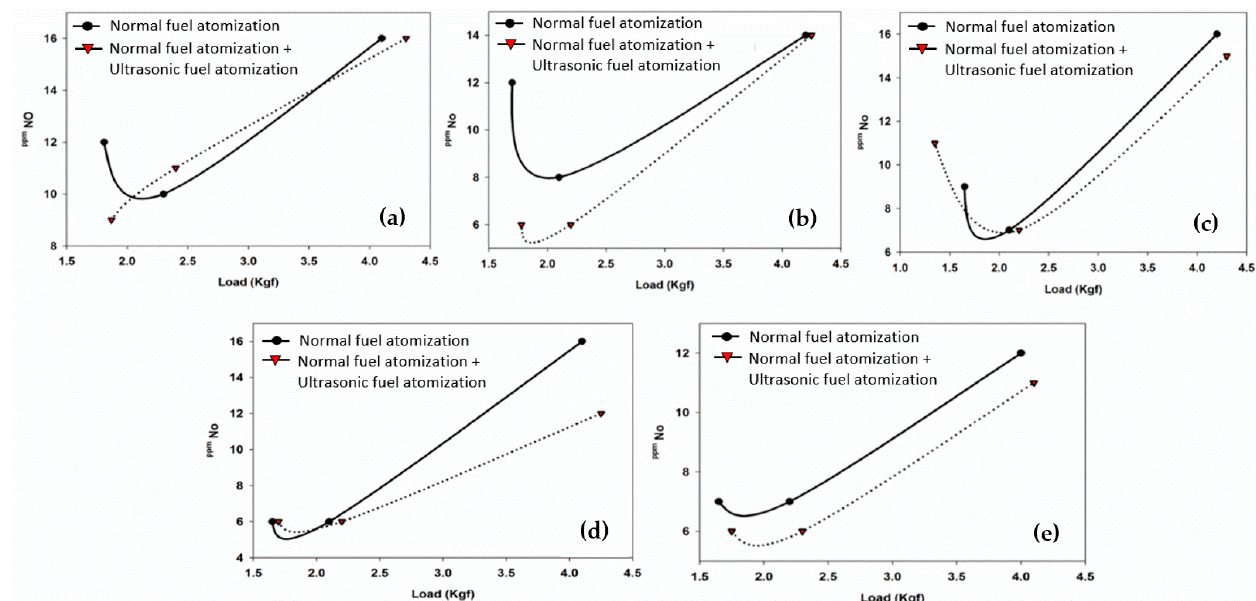
Figure 6. Plots of NO emissions against the engine load for all the different fuel types: ( a ) kerosene, ( b ) B20, ( c ) B50, ( d ) B75 and ( e ) B100.